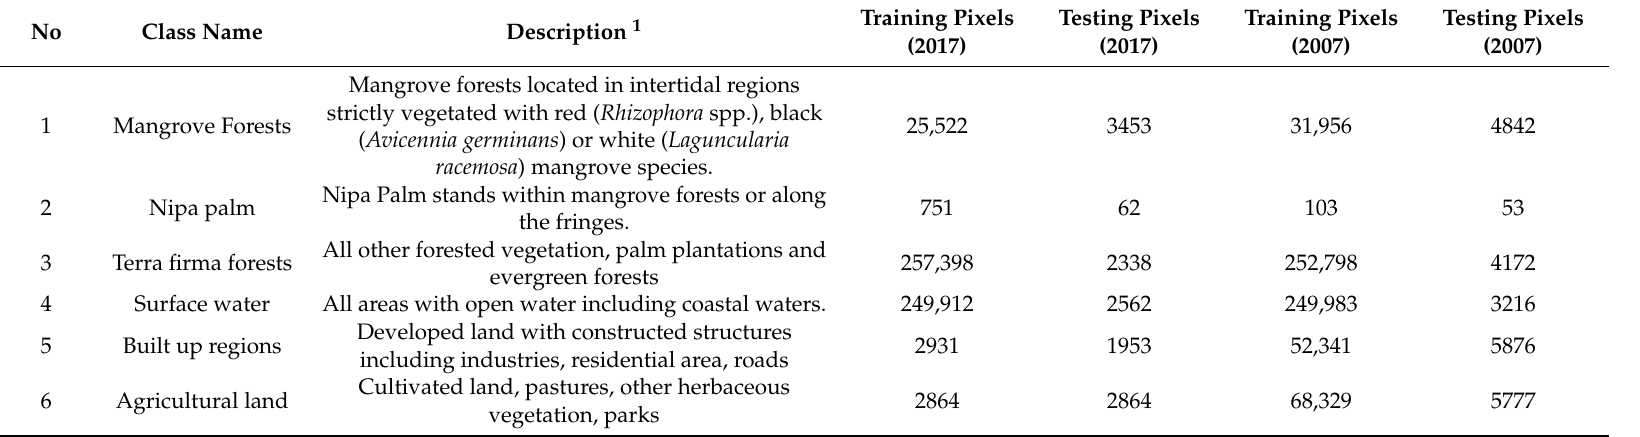
Table 1. Number of pixels from Google Erath generated polygons of land cover classes for 2007 and